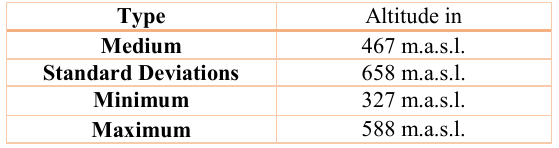
Figure 9. Visibility, example of the sites Dar Qita and Ma‘ez.